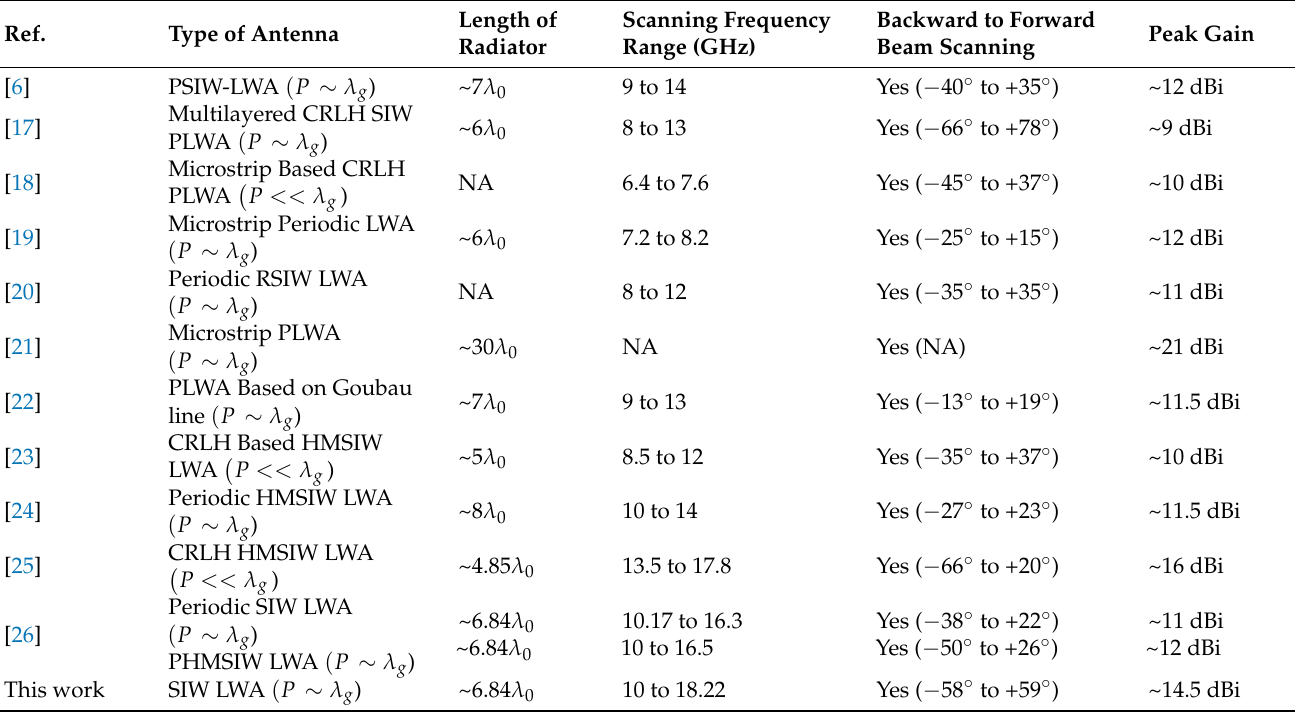
Figure 10. Simulated and measured gain patterns for SIW LWA. Table 2. Shows a comparison to other reported designs.